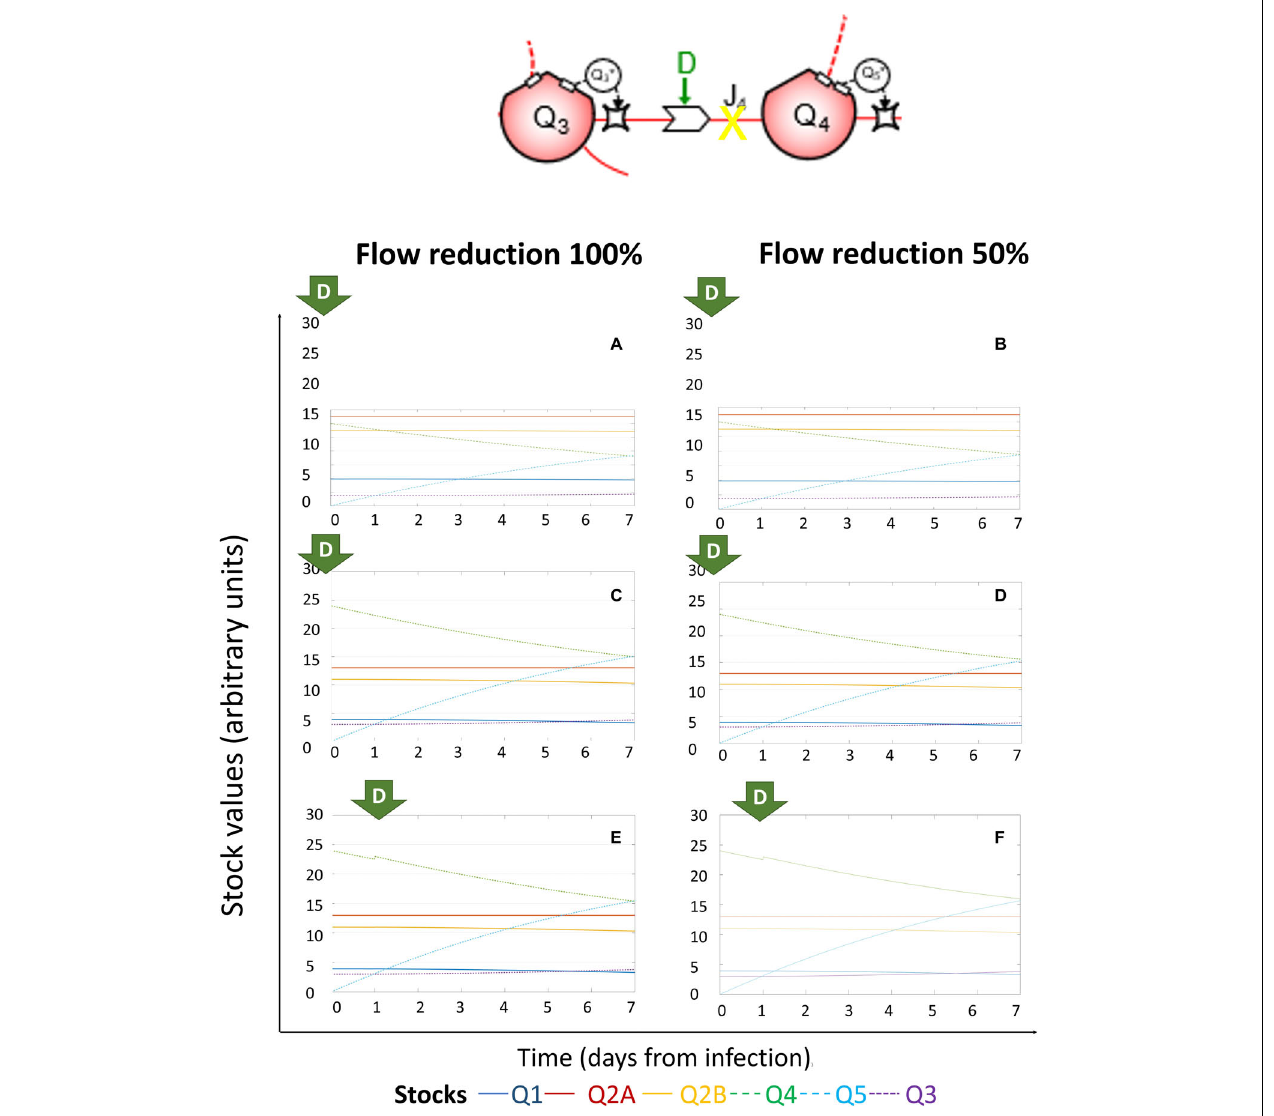
FIGURE 6 | System dynamics of (+)ssRNA virus–host interaction in response to external driving forces applied to reduce viral protein synthesis. Changes over time of the values of each stock of the system diagrammed in Figure 1 (for the color code, see bottom), expressed in ATP-eq, in response to reduction of J 4 (flow of energy required for viral RNA translation and viral protein synthesis). Several scenarios are shown: initial viral load 5k and application of full (100%, A ) or partial (50%, B ) J 4 reduction at Day 0; initial viral load 10k and application of full (100%, C ) or partial (50%, D ) J 4 reduction at Day 0; initial viral load 10k and application of full (100%, E ) or partial (50%, F ) J 4 reduction at Day